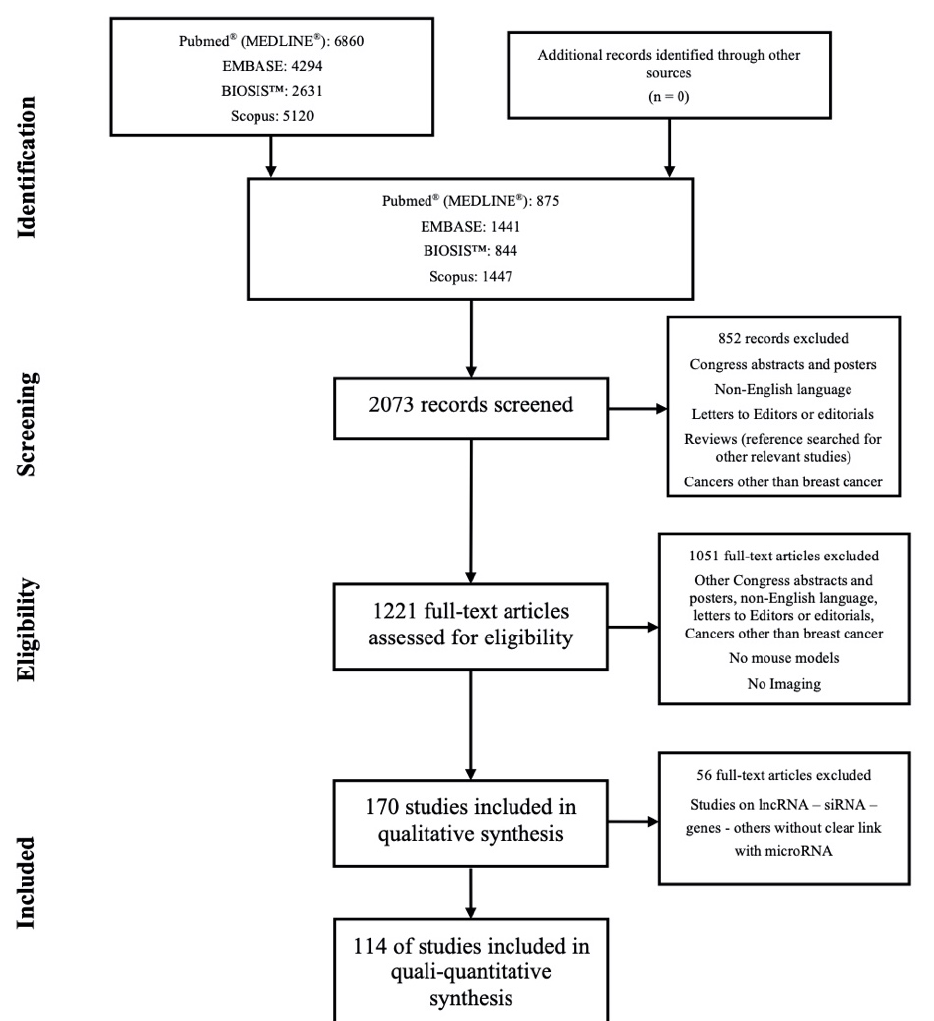
Figure 1. Flowchart for the strategy searches .